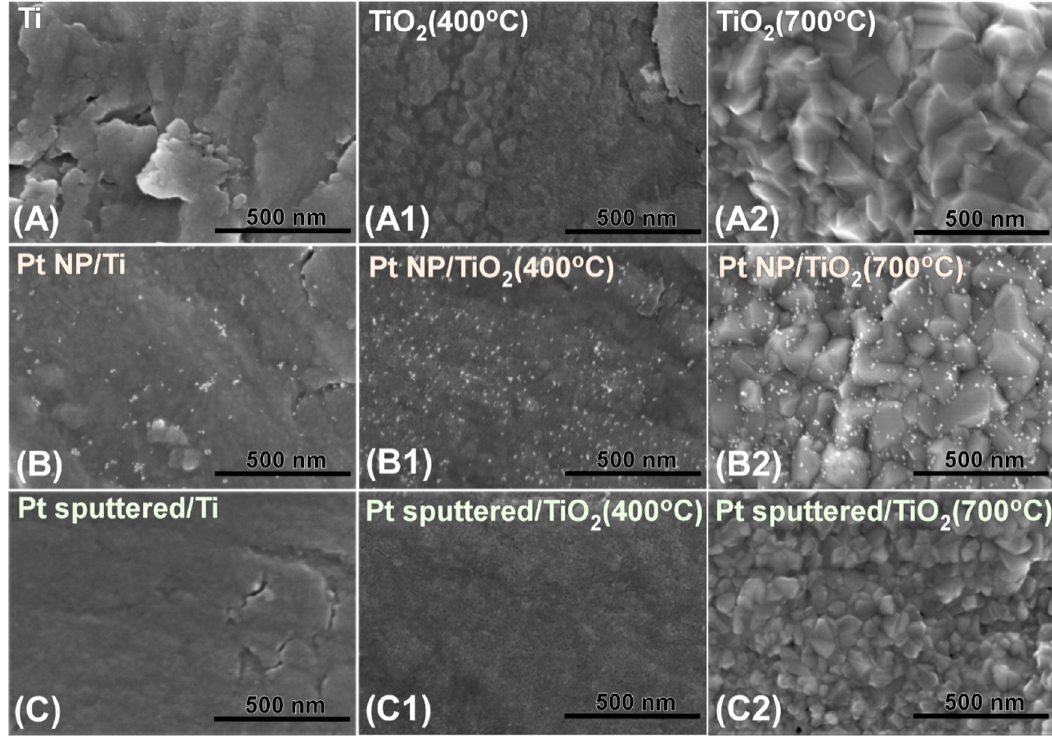
Figure 1. Scanning electron microscope (SEM) images of: ( A ) bare Ti; ( A1 ) bare Ti (400 ◦ C); ( A2 ) bare Ti (700 ◦ C); ( B ) Pt NP / Ti; ( B1 ) Pt NP / Ti (400 ◦ C); ( B2 ) Pt NP / Ti (700 ◦ C); ( C ) Pt-sp / Ti; ( C1 ) Pt-sp / Ti (400 ◦ C); ( C2 ) Pt-sp / Ti (700 ◦ C) samples.